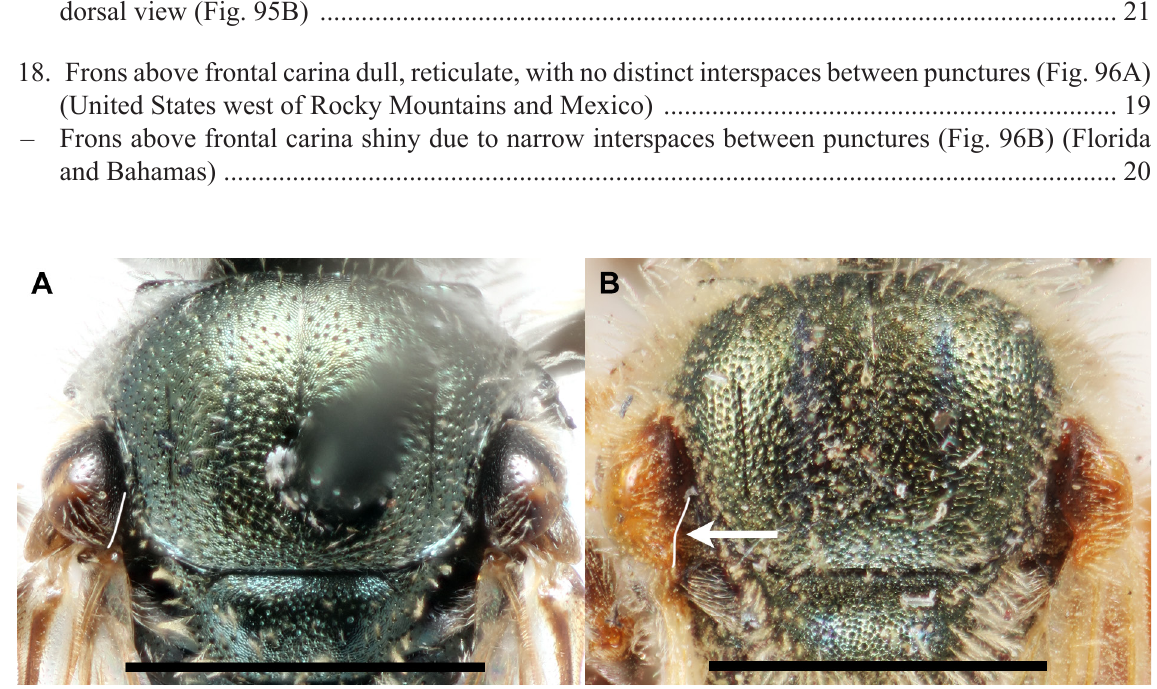
Fig. 95. Tegulae. A . Lasioglossum holzenthali sp. nov., ♀, not reaching posterior margin of mesoscutum and inner posterior margin straight (outline on left). B . L. ellisiae (Sandhouse, 1924), ♀, reaching posterior margin of mesoscutum and inner posterior margin concave (arrow and outline on left). Scale bars = 1 mm.